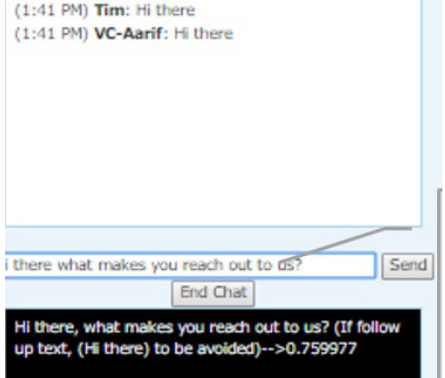
Figure 17. The Counsellor uses the hint to respond to the Client